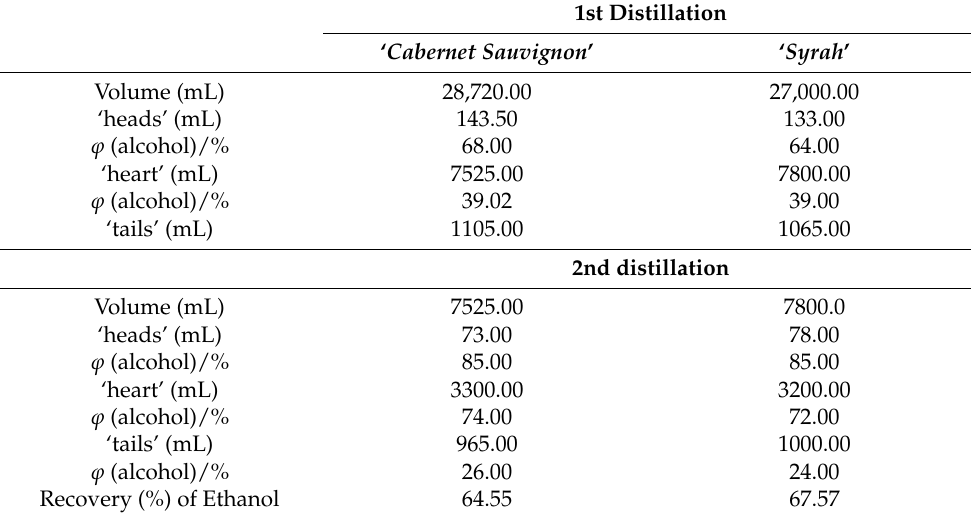
Table 3. Distillation